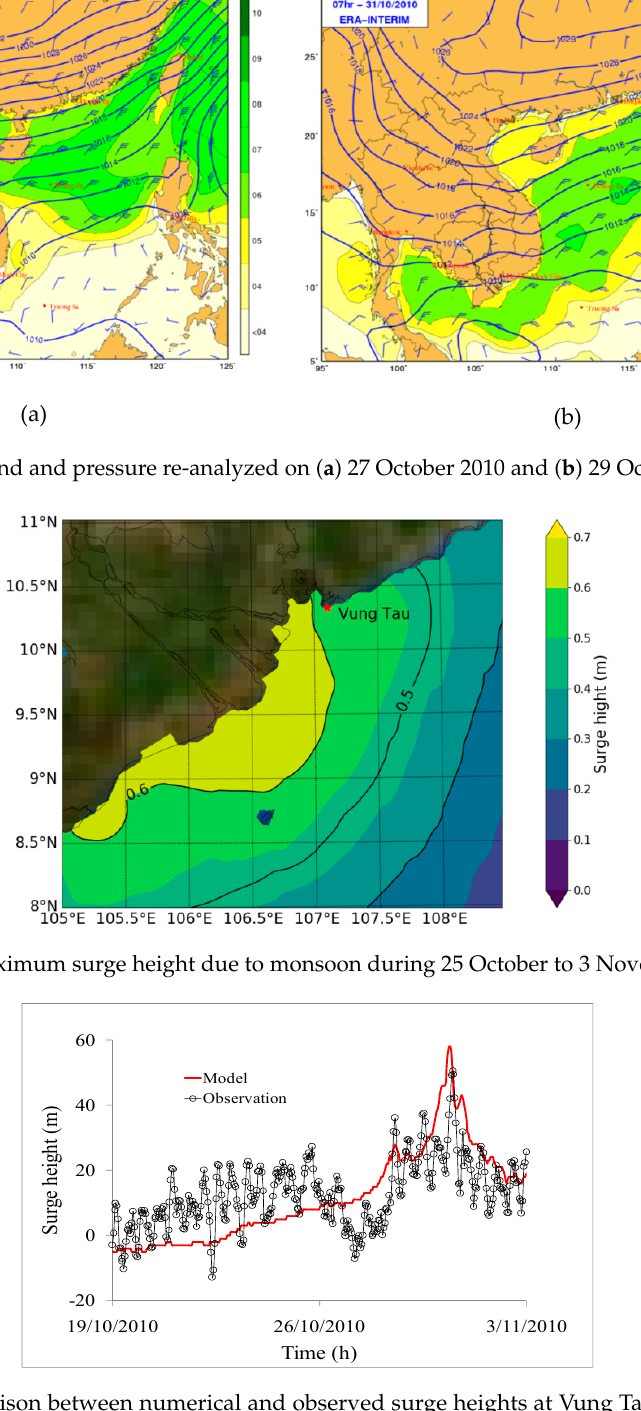
Figure 13. Comparison between numerical and observed surge heights at Vung Tau station during 25 October to 3 November 2010.